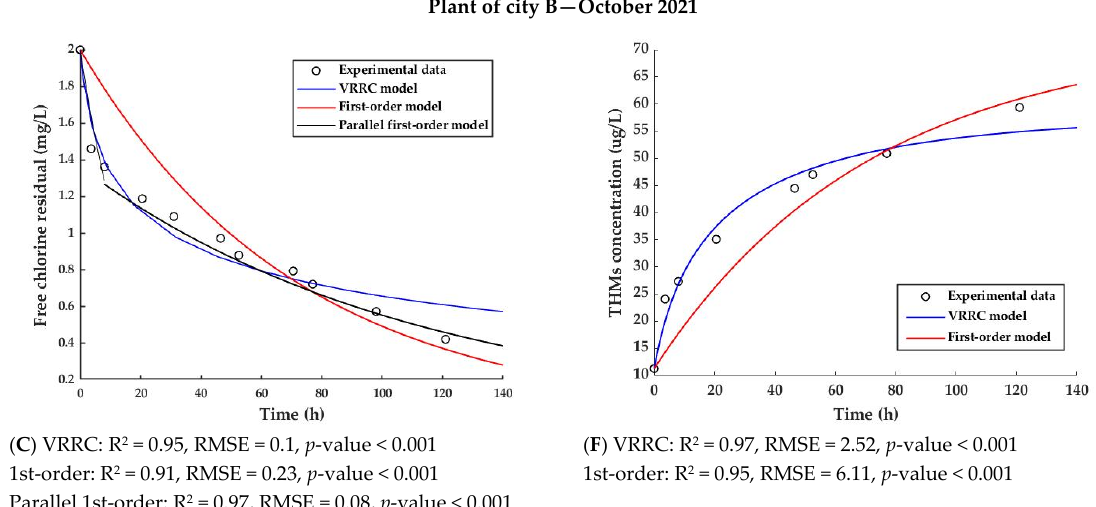
Figure 4. Curve fitting results and goodness of fit for chlorine and THMs; comparison with the 1st-order and the parallel 1st-order model.